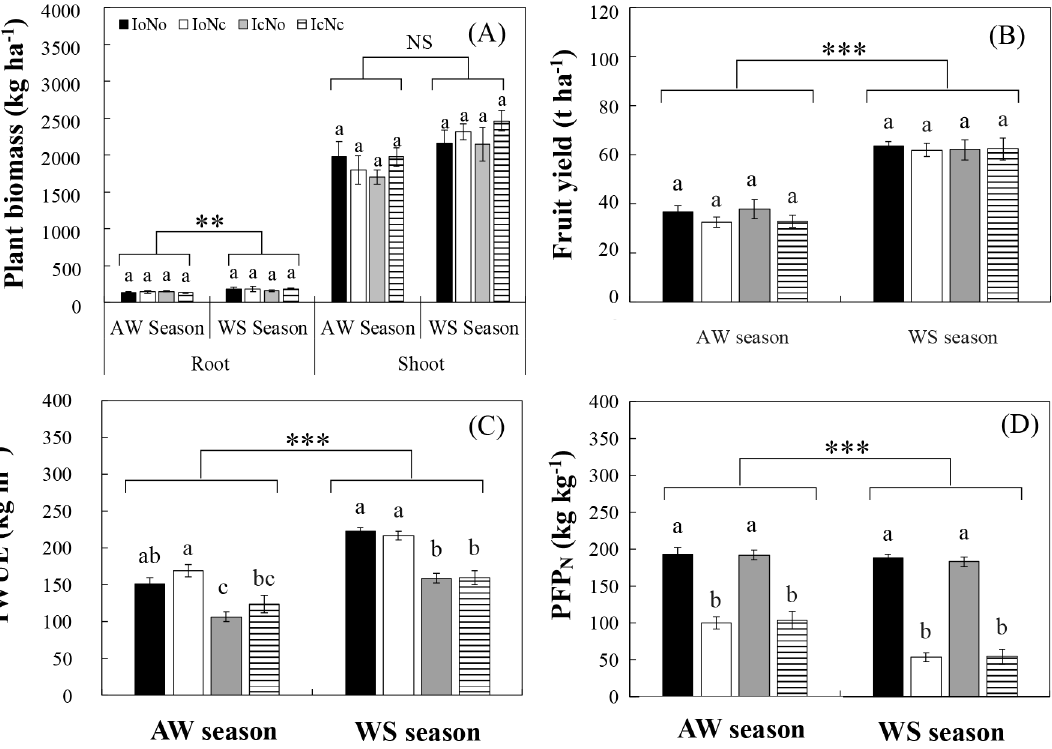
Fig 8. Plant biomass (A), fruit yield (B), irrigation water use efficiency (IWUE, C) and partial factor productivity of nitrogen (PFP N , D) under different treatments in the autumn-winter (AW) and winter-spring (WS) seasons. Treatments codes are the same as in Table 1. Bars represent standard errors (n = 4). The same letter in the same cropping season indicates no significant difference (A, C, D), and the same letter in the two cropping season indicates no significant difference (P = 0.05). (cid:3)(cid:3) P < 0.01, (cid:3)(cid:3)(cid:3) P < 0.001, NS: not